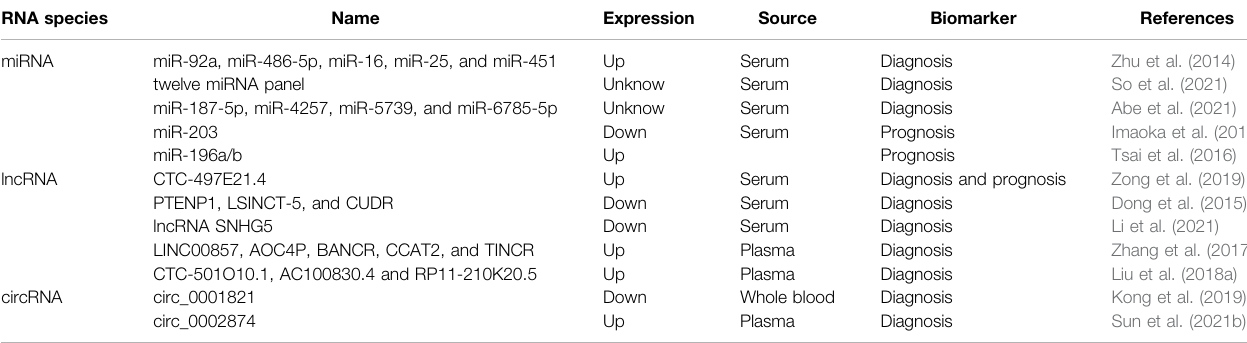
TABLE 2 | Circulating ncRNAs with potential diagnostic or prognostic role in GC. RNA